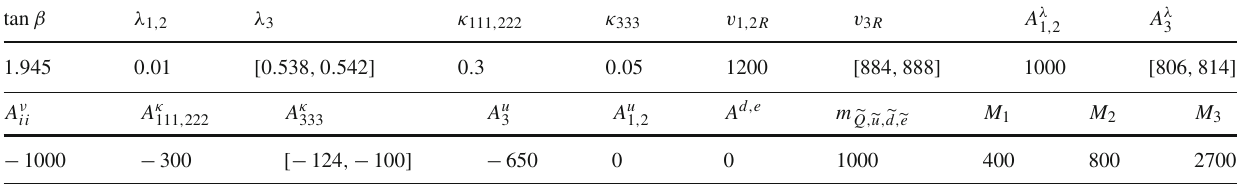
Fig. 9 Values for μ LEP (top) and for μ CMS (bottom) for each parameter point versus the mass of (cid:4) ν R τ . The colors indicate the R mass of the SM-like Higgs